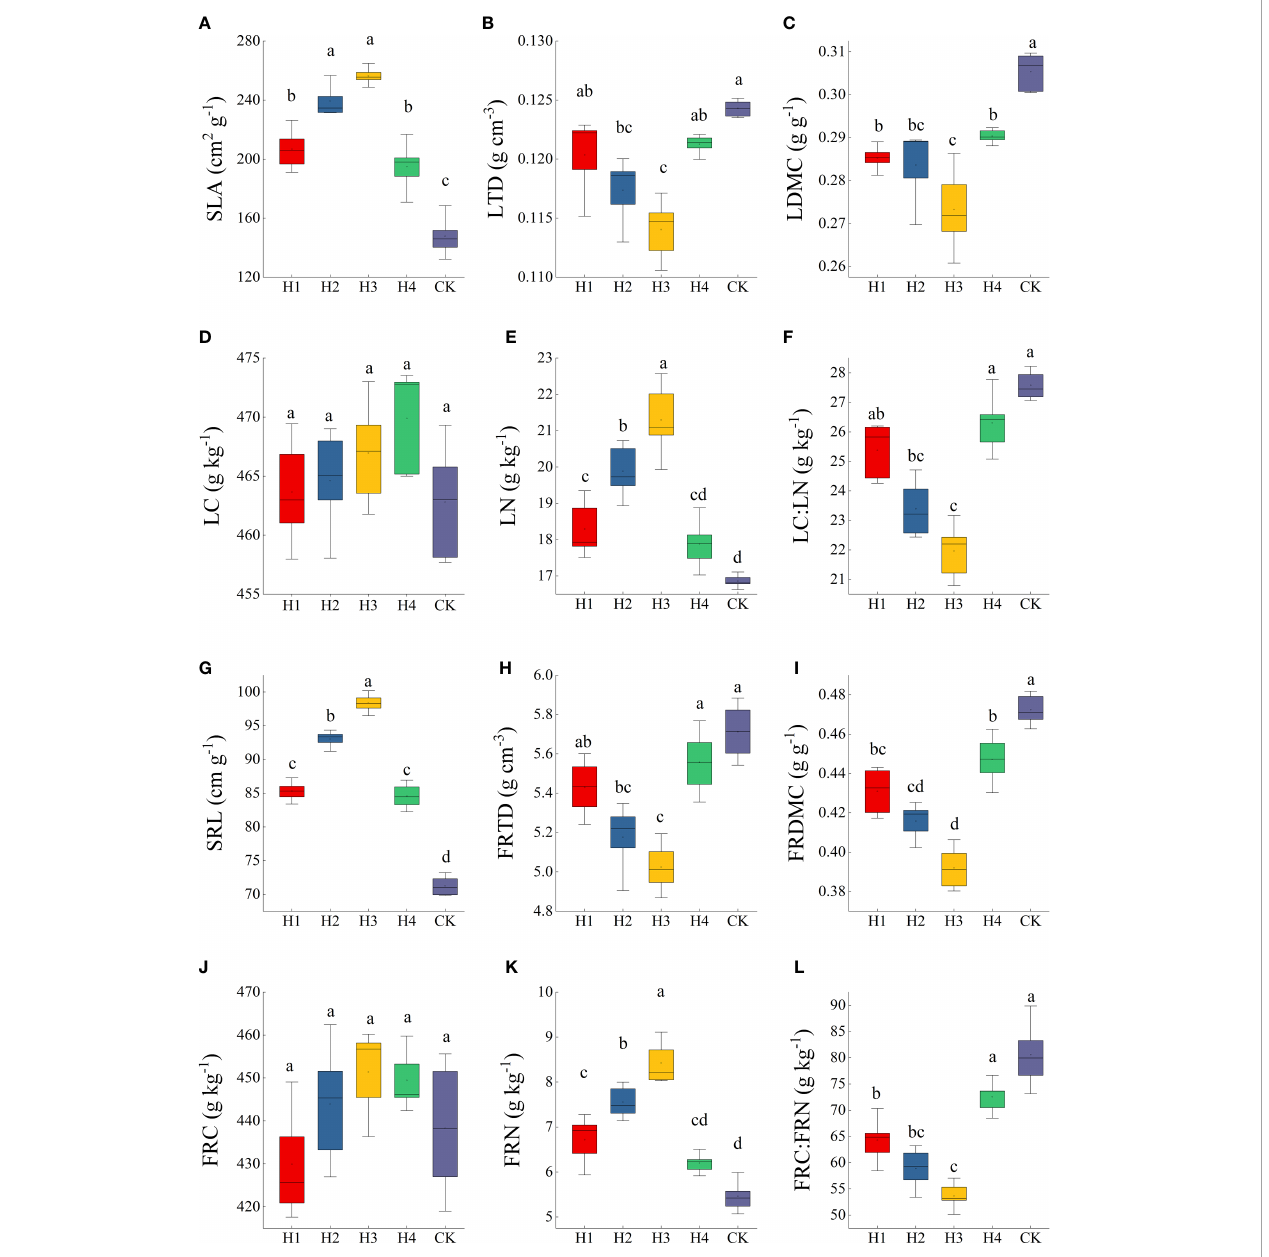
FIGURE 4 The traits of leaves (A – F) and fi ne roots (G – L) at different stump heights. Error bars represent ± SE of the mean. Signi fi cant differences are indicated by different lowercase letters at p < 0.05. (All abbreviations are shown in (Figure